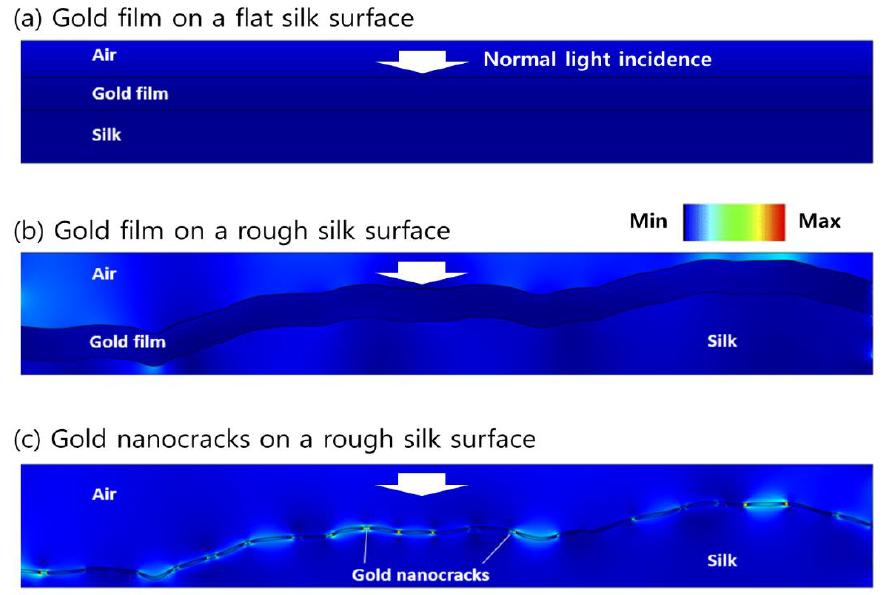
Figure 7. Numerical analyses on local field enhancement using FEM method. Field distributions of SERS substrate for ( a ) a 40 nm thick gold film on a flat silk substrate, ( b ) a 40 nm thick gold film on a rough silk substrate, and ( c ) a 3 nm thick gold nanocracks on a rough silk substrate. FEM models of rough silk surface were prepared using real AFM data with a surface roughness of 38.55 nm. Monochromatic light of λ = 785 nm was assumed as a normal incidence of a unit amplitude.